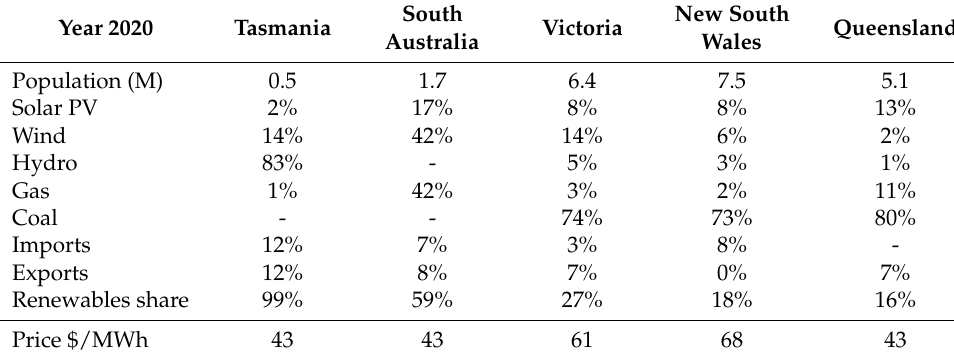
Table 1. Population, energy technology share and NEM spot price in